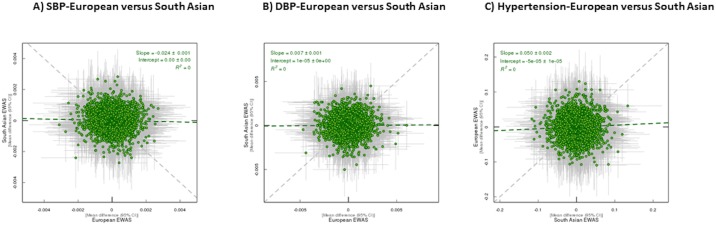
Consistency between fully adjusted EWAS of SBP, DBP and hypertension between Europeans and South Asian.DNA methylation associations are shown for 402331 common CpG sites across three EWAS analyses. Each green dot represents a CpG site and the positions of the dots are determined by the effect size in each analysis. The grey lines on each dot denote the confidence intervals (CI) for the estimates. A linear fit of the overall correspondence summarises correlation between compared associations (green dashed line). Grey dashed line shows the line of equality in effect sizes between pairs of analyses. R2 = goodness of linear fit and as such is a measure of the consistency between two EWAS.